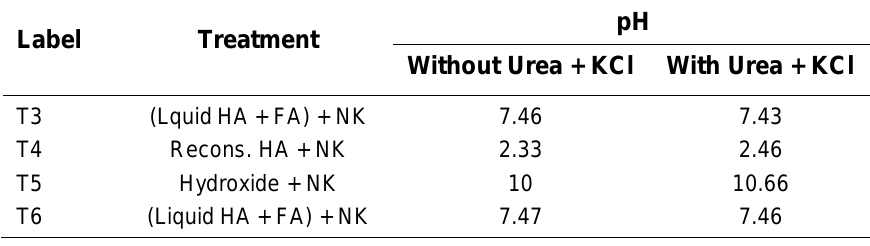
pH Values of Treatments Before and After Fertilizer Formulation